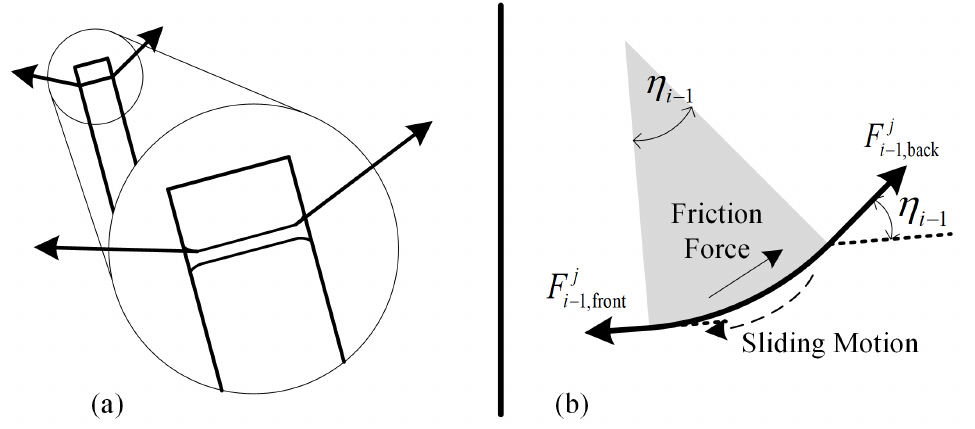
Figure 5. Cable hole friction model. ( a ) Cable and hole contact diagram. ( b ) Force and motion